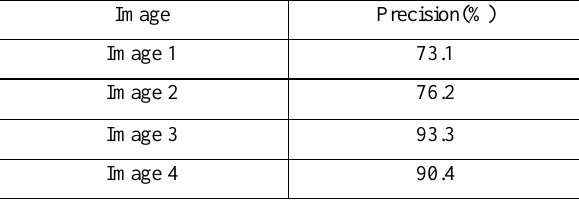
Table.3 Precision of building angles